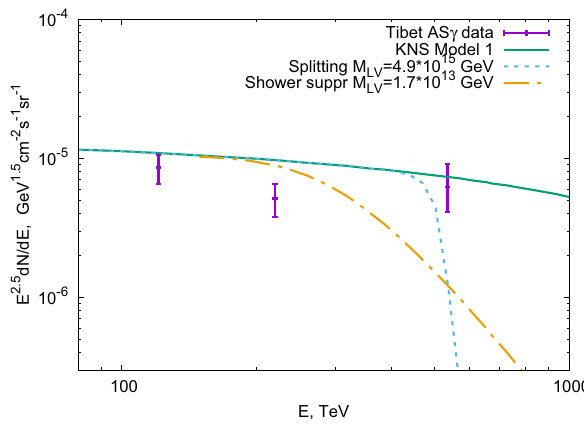
Fig. 1 Diffuse gamma ray flux measured by Tibet-AS γ from the outer Galactic disk (data points) [9], Model 1 of Koldobskiy et al. [36] for the flux from the outer Galactic disk (green solid curve), the prediction of superluminal LIV model with M LV = 6 . 6 × 10 15 GeV (blue dashed curve),thepredictionofsubluminalLIVmodelwith M LV = 2 . 1 × 10 13 GeV (yellow dash-dotted